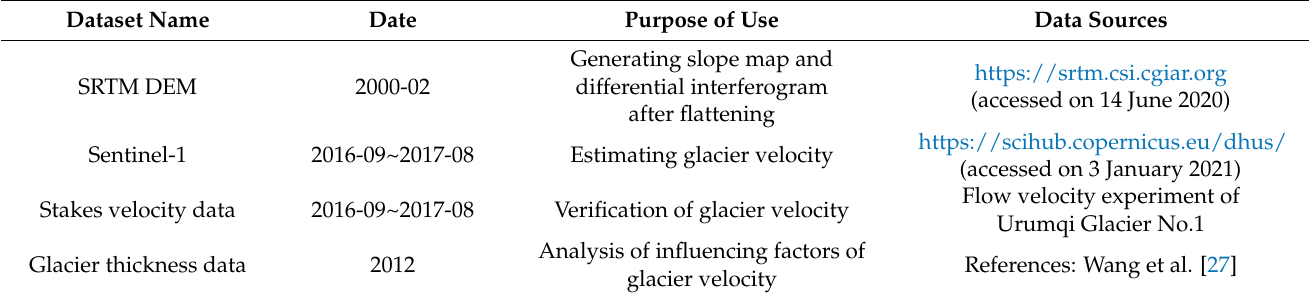
Table 1. Data used in this